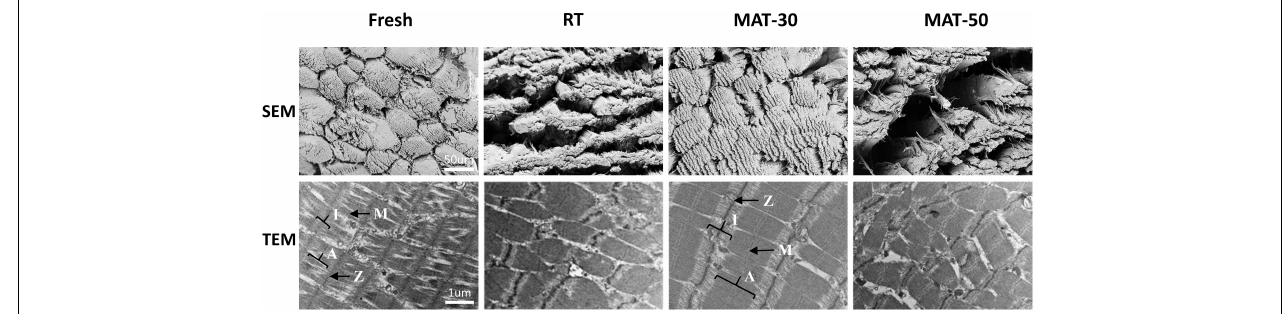
FIGURE 5 | Microstructure of frozen beef with different thawing treatments.